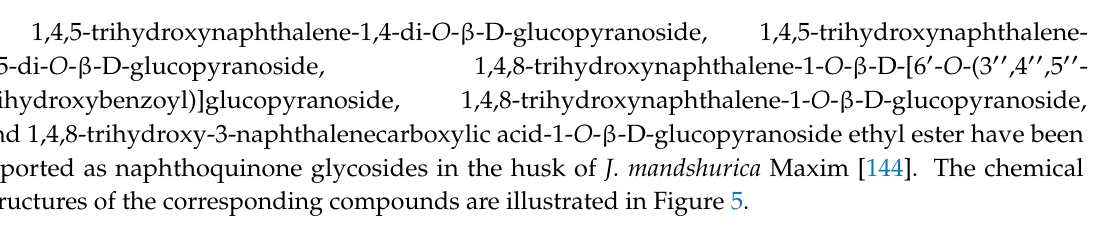
(cid:48) (cid:48)(cid:48) (cid:48)(cid:48) (cid:48)(cid:48) - O -(3 ,4 ,5 -